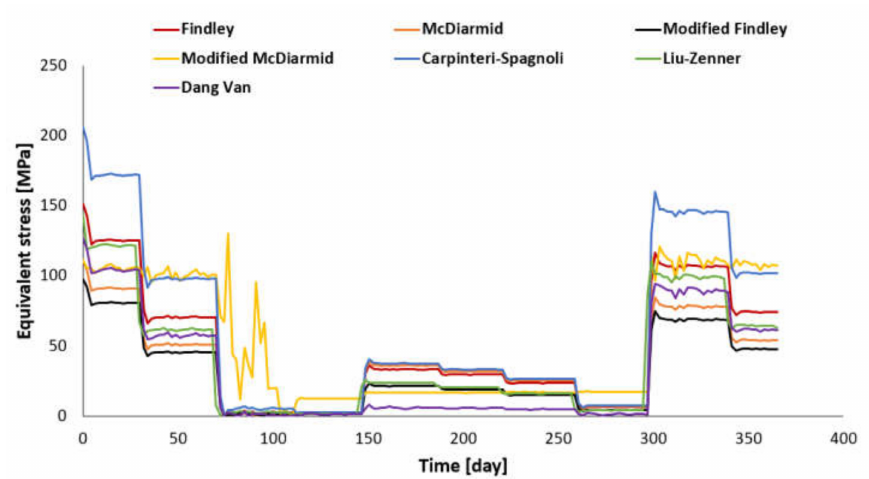
Figure 13. The time history of equivalent stress utilizing various criteria (element No. 38732 in the coupling structural-thermal analysis due to temperature variations).